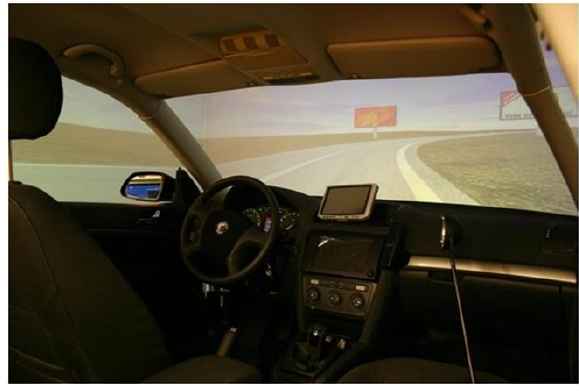
Figure 3. Škoda Octavia II mock-up.